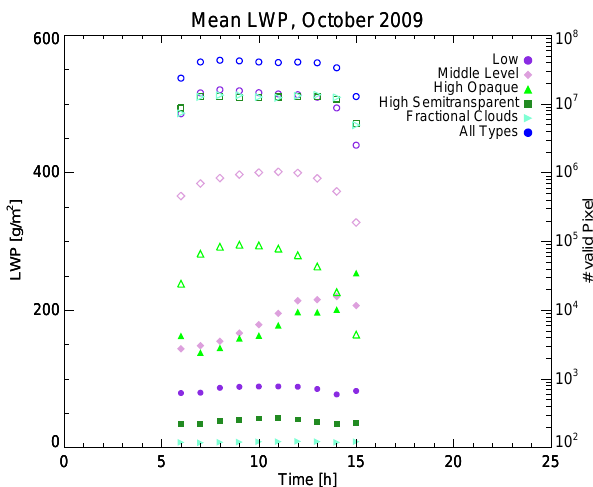
Fig. 6. Average diurnal cycle of LWP for distinct cloud types (filled symbols) and the corresponding number of occurrence (correspond- ing open symbols), October 2009. Level 2 data from the North- ern Hemisphere of SEVIRI disc were considered; cloud-free pixels were not included in the average, i.e. variations in the average are caused by intrinsic LWP